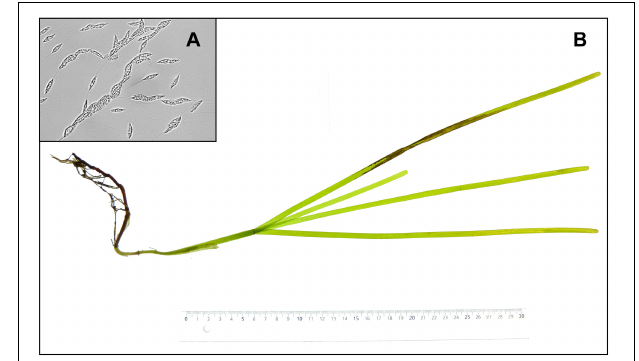
FIGURE 1 | (A) Labyrinthula zosterae cells on an agar plate, (B) necrotic lesions on a Zostera marina shoot following inoculation with L. zosterae